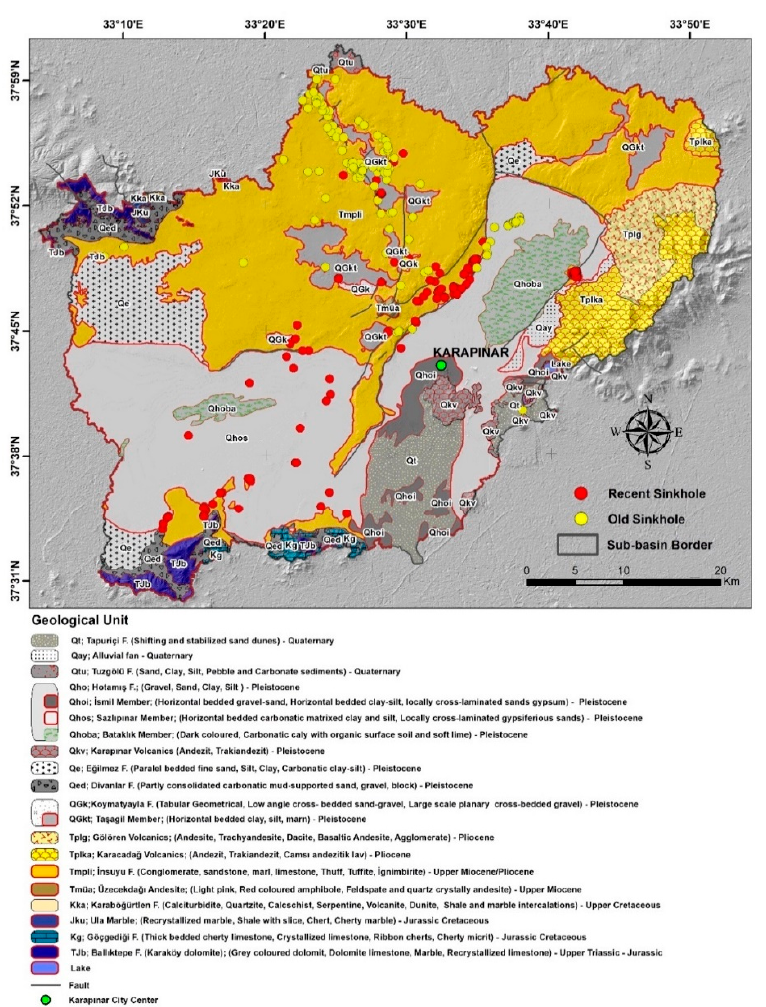
Figure 2. Geology map (modified from [41]) with a distribution of 332 sinkholes in the study area. The grey line marks a fault. The yellow and red circles mark old and recent sinkholes, respectively.